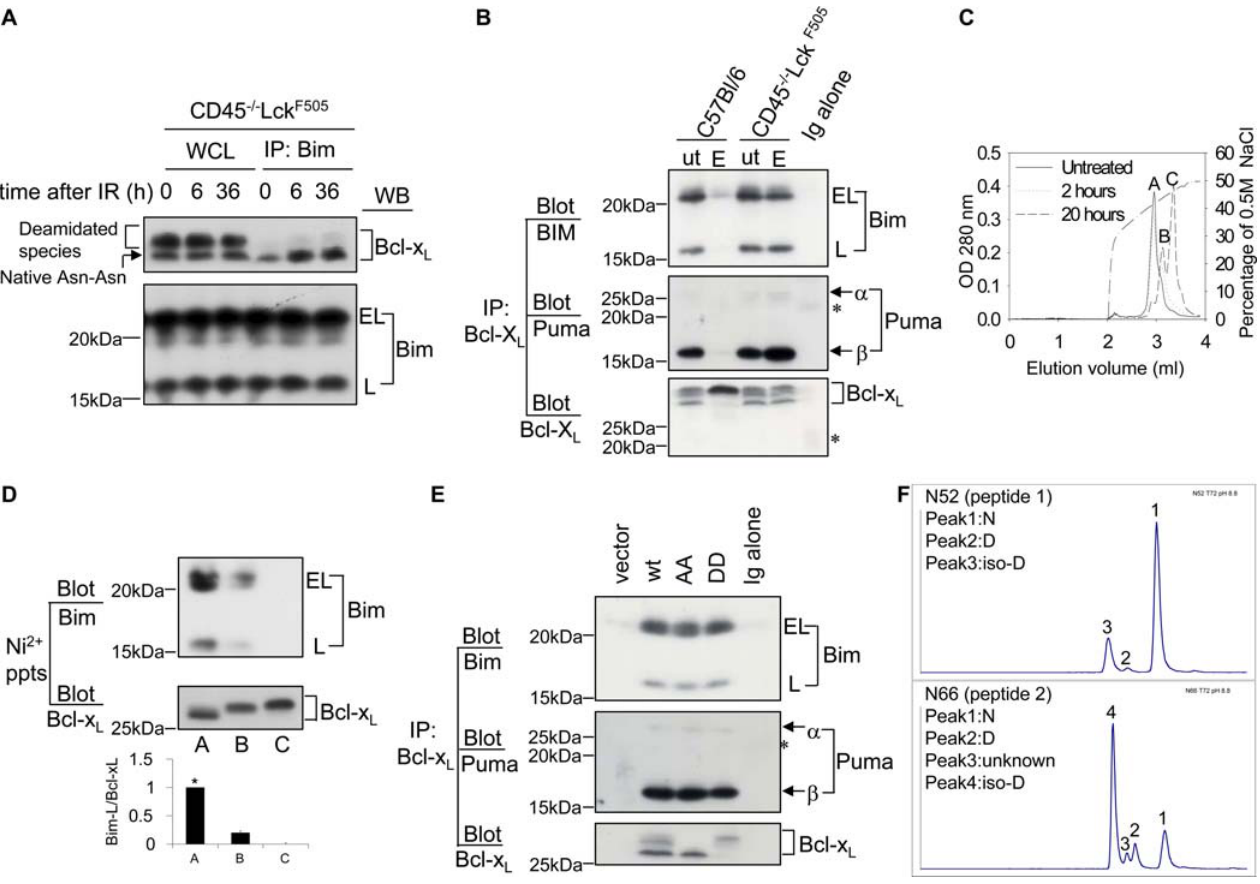
Figure 2. Deamidation Disrupts the Sequestration of BH3-Only Proteins by Bcl-x L (A) Bim binds to the native (Asn-Asn) but not deamidated forms of Bcl-x L . Wild-type (C57BL/6) thymocytes (1.5 3 10 7 ) were exposed to 5 Gy irradiation (IR) and then maintained in culture for the times shown, after which cells were lysed and either separated as whole cell lysates (WCL) or as Bim immunoprecipitates, followed by immunoblotting for either Bcl-x L or for Bim. Bim migrates as ‘‘ extra-long ’’ (EL) or ‘‘ long ’’ (L) forms. (B) Bcl-x L was immunoprecipitated from lysates derived from purified DN thymocytes treated with/without etoposide (ut/E), followed by immunoblotting for Bim or Puma. The asterisk indicates the light chain of the Bcl-x L antibody used for immunoprecipitation. (C) Anion exchange chromatography of purified rBcl-x L . Sample A was untreated; samples B and C were exposed to pH 8.8 at 37 8 C for 2 h and 20 h, respectively. The Figure illustrates superimposed elution profiles for each sample. Peaks A, B, and C had molecular masses of 25, 015.6; 25, 016.4, and 25, 017.2, respectively. (D) Bim binds to native but not to deamidated rBcl-x L . The three different forms of Bcl-x L (A, B, and C) purified by anion-exchange column chromatography shown in (C) were incubated in wild-type thymic lysates (1.5 3 10 7 cell equivalents) at 4 8 C for 2 h and then precipitated using nickel beads. The precipitated products were immunoblotted for Bim and Bcl-x L . Quantification of the Bim-L/Bcl-x L ratios 6 SD from three independent experiments is shown in the histogram, with the lane A ratio normalised to 1 (*). (E) Primary thymocytes were retrovirally transduced with empty vector or Bcl-x L constructs (wild-type, N52A-N66A, or N52D-N66D). Bcl-x L was immunoprecipitated from lysates derived from 1.5 3 10 6 sorted GFP-positive cells per lane, followed by immunoblotting for Bim or Puma. Note that in the vector lane, at this exposure endogenous Bcl-x L is not visible because of the small number of cells used. The asterisk indicates the light chain of the Bcl-x L antibody used for immunoprecipitation. (F) Peptides SDVEENRTEAPEGTESEMETPSAINGNPSW (peptide 1) and HLADSPAVNGATGHSSSL (peptide 2), and the corresponding deamidated forms, containing the putative deamidation sites N52 and N66, respectively, were generated by digestion of rBcl-x L with chymotrypsin. The chromatographic conditions used for the separation of the peptides in the LC-MS analyses were optimised so as to resolve the Asn, Asp, and iso-Asp forms of peptides 1 and 2. The Asp and iso-Asp forms of the two peptides were identified by spiking an aliquot of a digestion mixture with Asp- or iso-Asp–containing synthetic peptides prior to LC-MS (Figure S3). The chromatograms show LC-MS analyses at time point 72 h of the rBcl-xl base treatment. For both peptides, the major deamidation product is the iso-Asp form; the iso-Asp:Asp ratios are approximately 10:1 for N52 and 5:1 for N66. The unknown peak 3 in peptide 2 could be an isomer of peak 2 or peak